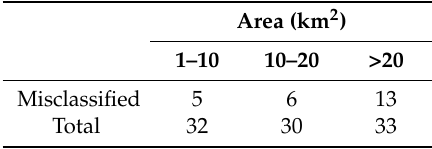
Table 7. Misclassified numbers of dark regions.